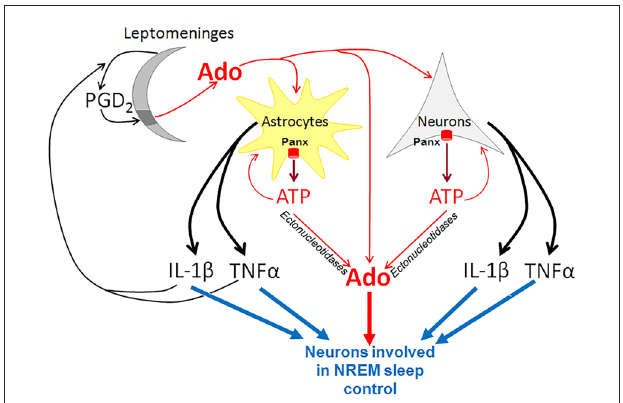
FIGURE 1 | Pannexins (Panx) in purinergic control of non-rapid eye movement (NREM) sleep. In neurons and astrocytes, Panx proteins form plasma membrane hemichannels that are highly permeable for ATP. ATP is rapidly converted by ectonucleotidases to adenosine (Ado), which inhibits wake-active neurons and promotes the activity of sleep-active neurons in the basal forebrain. ATP also activates glial and neuronal P2 receptors and stimulates production of potent somnogenic substances such as TNF α and IL-1 β . In addition, leptomeninges produce prostaglandin D2 (PGD2) that binds to its receptors solely in the meningeal area underlying the basal forebrain (dark gray). This binding results in elevation of Ado concentration in the basal forebrain parenchyma. TNF α and IL-1 β derived from astrocytes and neurons stimulate the synthesis of PGD2. ablation of A 2A -receptors (Zhang et al., 2017). Activation of